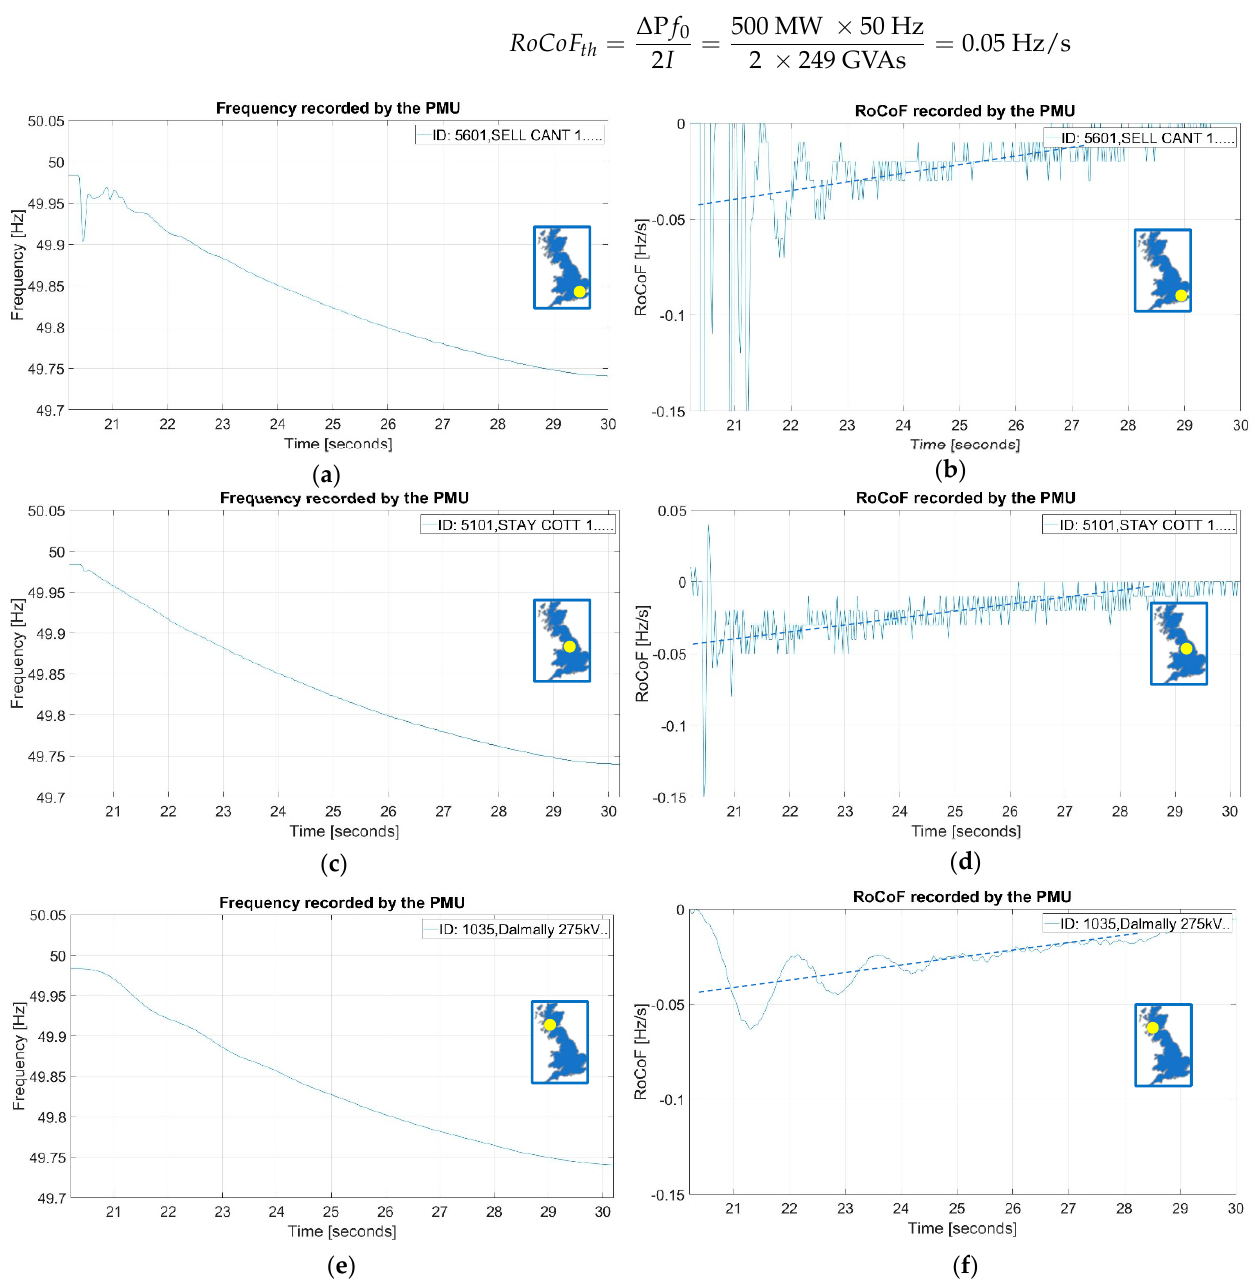
Figure 11. HVDC trip PMU data (frequency and RoCoF) for the selected locations: Sellindge, Staythorpe, and Dalmally.